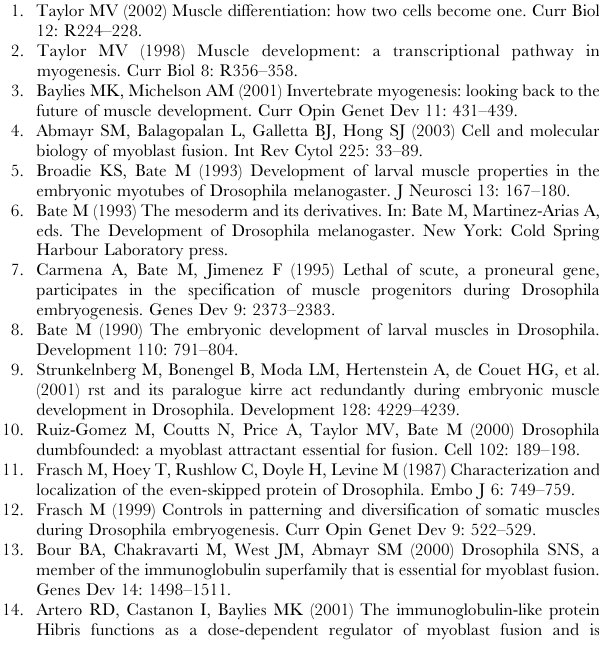
Figure S6 Expression levels of Duf truncations. Flag tagged Duf transgenes were over expressed under daughterless-GAL4 at 25 u C. Western blot was performed on extracts from these embryos and probed with anti-Flag, to detect Duf. Tubulin was used as a loading control. The red asterisk indicates the relevant band for each construct. All constructs were expressed at similar levels except UAS-Duf D CT5-flag , which was undetectable possibly due to masking of the Flag epitope. Table S1 Average number of nuclei in DA1 upon rescue of the duf, rst mutant DOC) Table S2 Fusion profile of duf, rst mutant embryos rescued with UAS-Duf D CT5-flag DOC) Supplementary Information File S1 Sequence information of primers used for mutagenesis and comparison of transmembrane